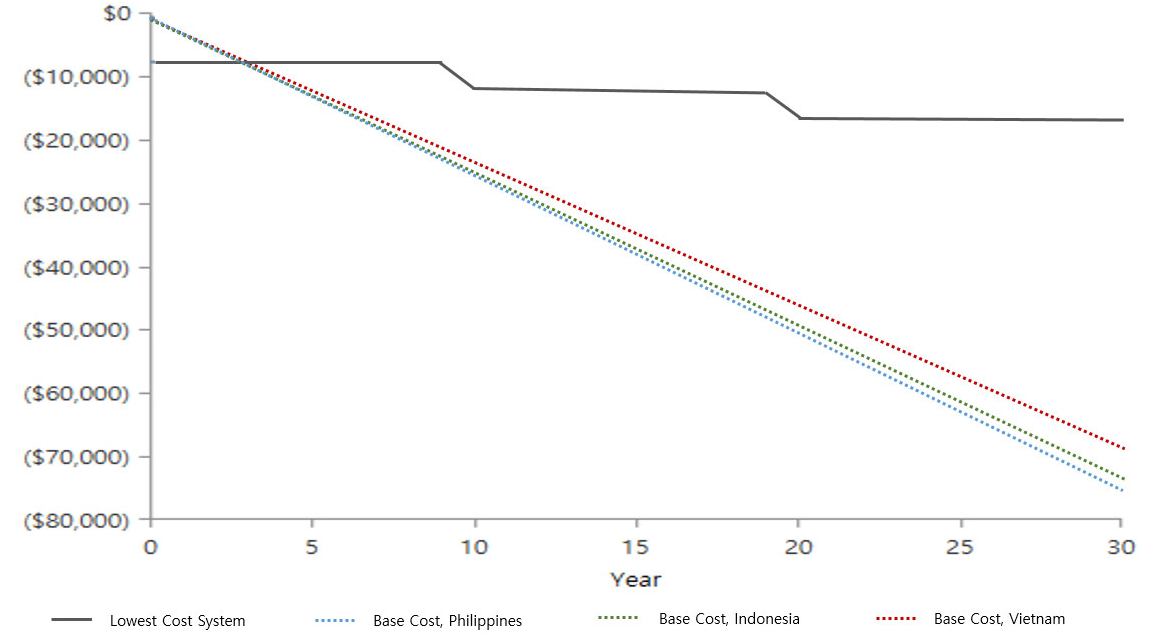
Figure 6. Economic feasibility of the proposed system compared with that of Base 1 system for the